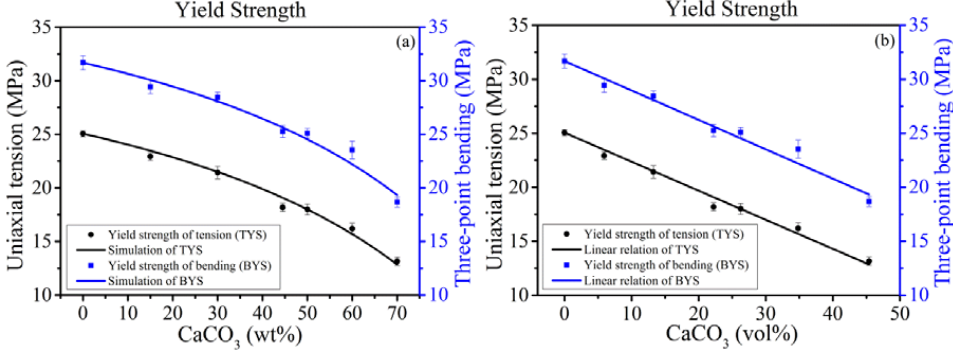
Table 1. The values of fitting parameters of two isotropic models. Parameters